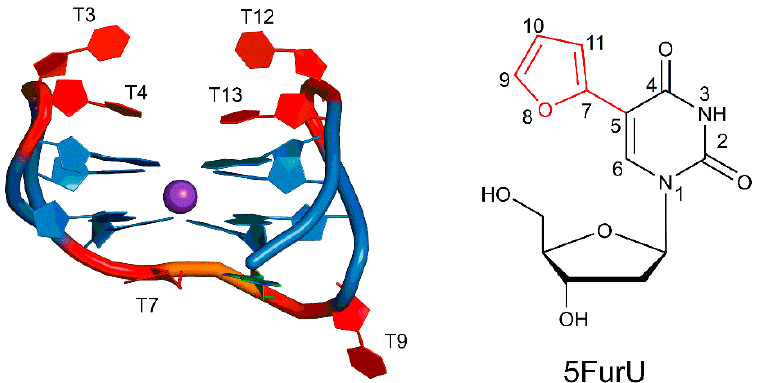
Figure 1. The thrombin-binding aptamer (TBA) antiparallel G-quadruplex, with T bases at six positions (3, 4, 7, 9, 12 and 13) highlighted in red and G-tetrads highlighted in blue (left), and the chemical structure of 5-furyl-2 ′ -deoxyuridine (5FurU, right).